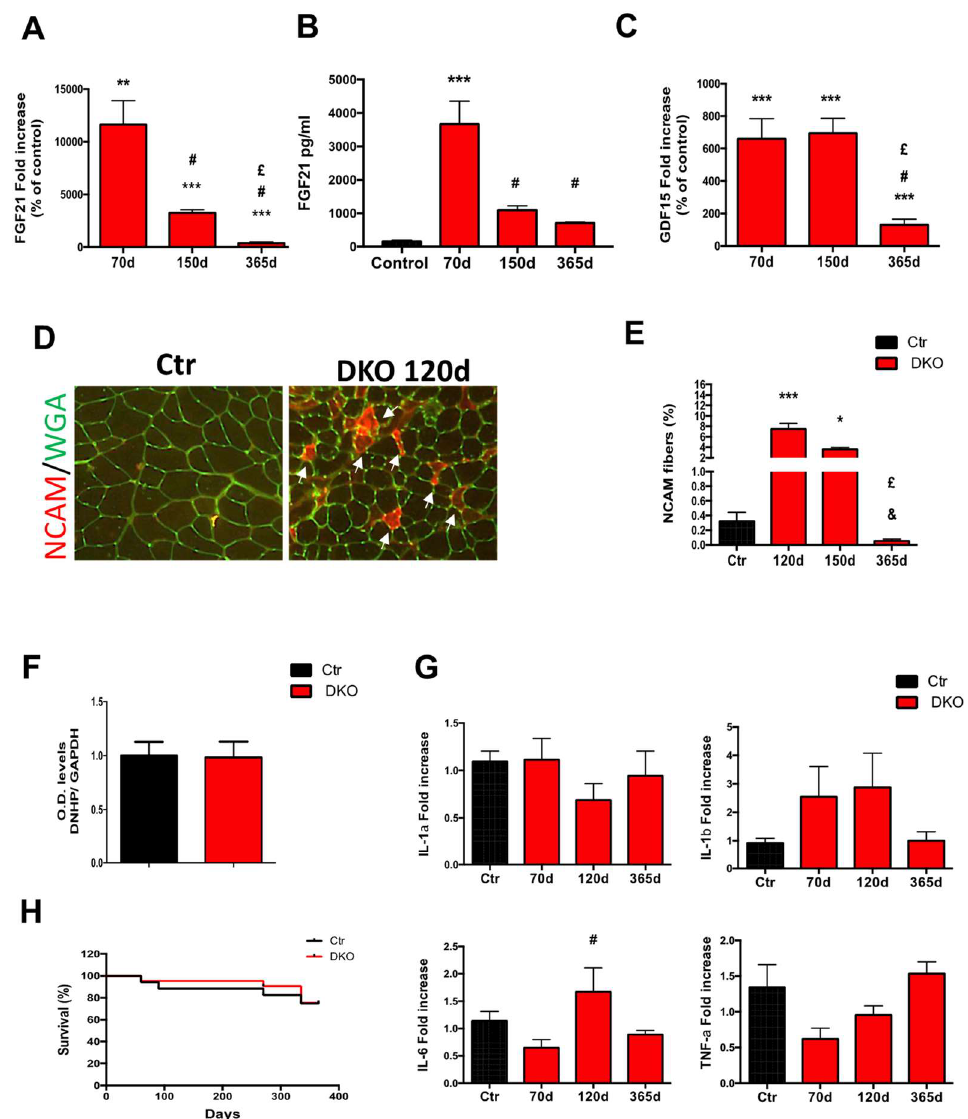
Figure 4. Inhibition of Drp1 in muscle-specific Opa1 knockout mice alleviates FGF21 induction, denervation, oxidative stress, inflammation and prevents mortality: ( A ) FGF21 mRNA GNM muscle levels and serum levels ( B ) of control and DKO mice; ( C ) GDF15 mRNA levels of control and DKO GNM muscles; ( D ) representative image showing NCAM-positive fibers in GNM DKO muscles (white arrows); ( E ) quantification of denervated NCAM-positive fibers of GNM muscles; ( F ) densitometric quantification of the carbonylated proteins in control and DKO soleus muscle extracts; ( G ) mRNA levels of the inflammatory cytokines IL-1 α , Interleukin 1-beta (IL-1 β ), IL-6, and Tumour Necrosis Factor-alpha (TNF α ) in GNM muscles. ( H ) Kaplan–Meier survival curve of DKO mice from the beginning of tamoxifen treatment (day zero). Data are shown as mean ± SEM. Two-tailed unpaired Student’s t -test and 2-way ANOVA were used. Statistical significance: * p < 0.05, ** p < 0.01, *** p < 0.001, compared to control; # compared to DKO 70d; & compared to DKO 120d; and £ versus DKO 150d.